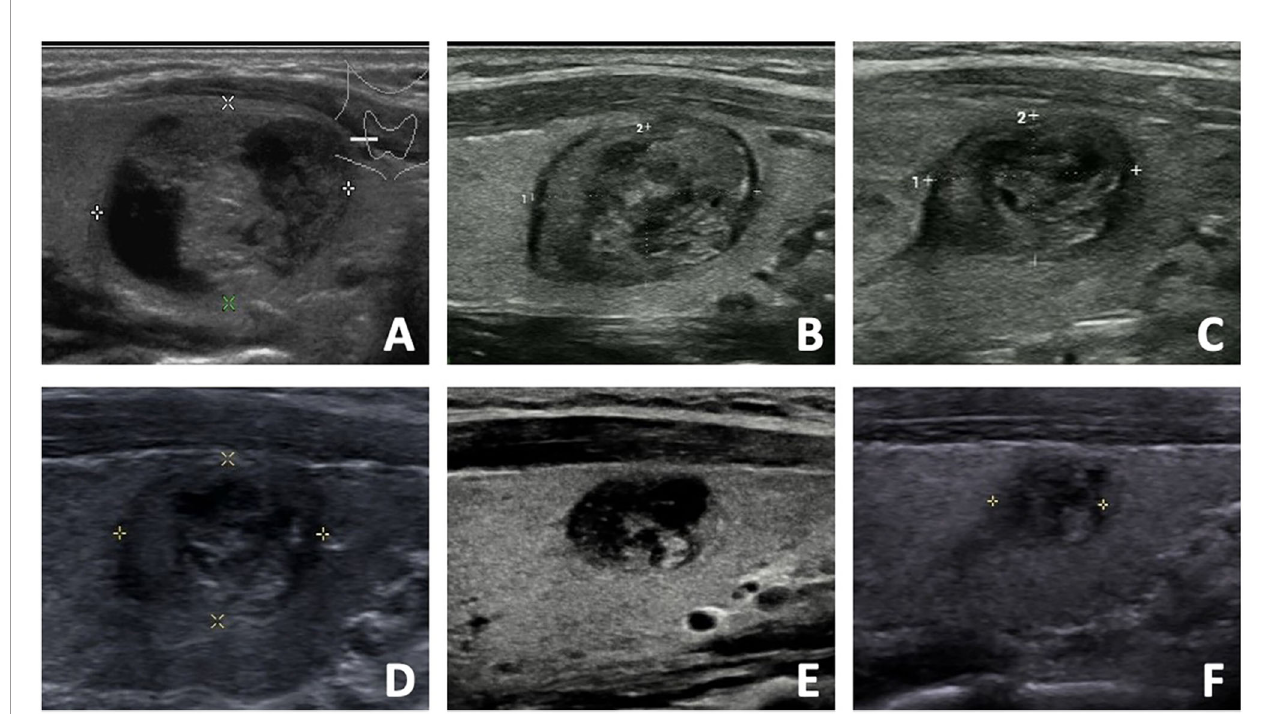
FIGURE 3 | The US images of a 33- year-old female with a benign thyroid nodule in the non-regrowth group. (A) The initial volume of nodule was 5.32 ml before RFA. The nodule was located in the normal location, and the vascularity was grade 1. The risk of regrowth by the nomogram was 2.1%. (B) At 1 month after RFA, the volume was 1.58 ml and VRR was 70.30%. (C) At 3 months after RFA, the volume was 0.88 ml and VRR was 83.46%. (D) At 6 months after RFA, the volume was 0.76 ml and VRR was 85.71%. (E) At 12 months after RFA, the volume was 0.32 ml and VRR was 93.98%. (F) At 18 months after RFA, the volume was 0.18 ml and VRR was 96.62%.